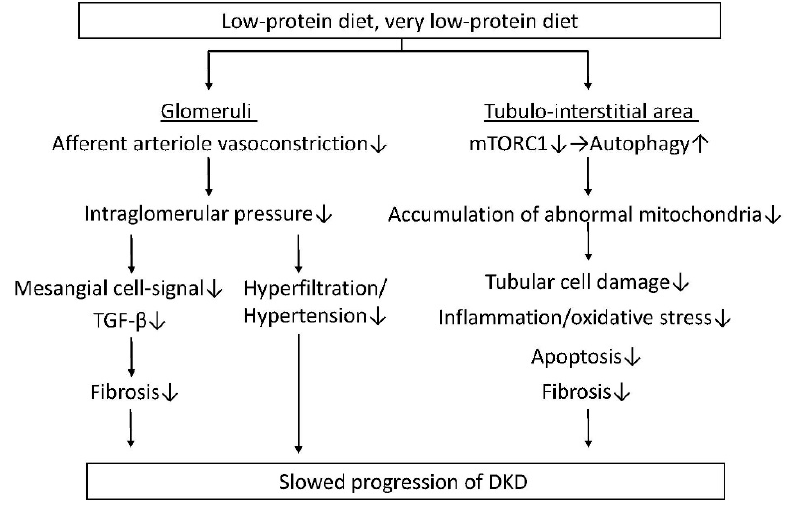
Figure 1. A low-protein diet (LPD) decreases intraglomerular pressure through the reduction of afferent arteriole vasoconstriction, resulting in the improvement of glomerular hyperfiltration and hypertension, and a reduction of fibrosis via growth factor- β (TGF- β ) signals in mesangial cells. In addition, an LPD, particularly a very-LPD (VLPD) reduces tubular cell damage, inflammation/oxidative stress, apoptosis and fibrosis in the tubule-interstitial area by decreasing the accumulation of abnormal mitochondria, which is induced by reducing the mammalian target of rapamycin complex 1 (mTORC1) activity, and restoring autophagy. An LPD may slow the progression of diabetic kidney disease through beneficial effects in both glomeruli and the tubule-interstitial area. DKD: diabetic kidney disease.